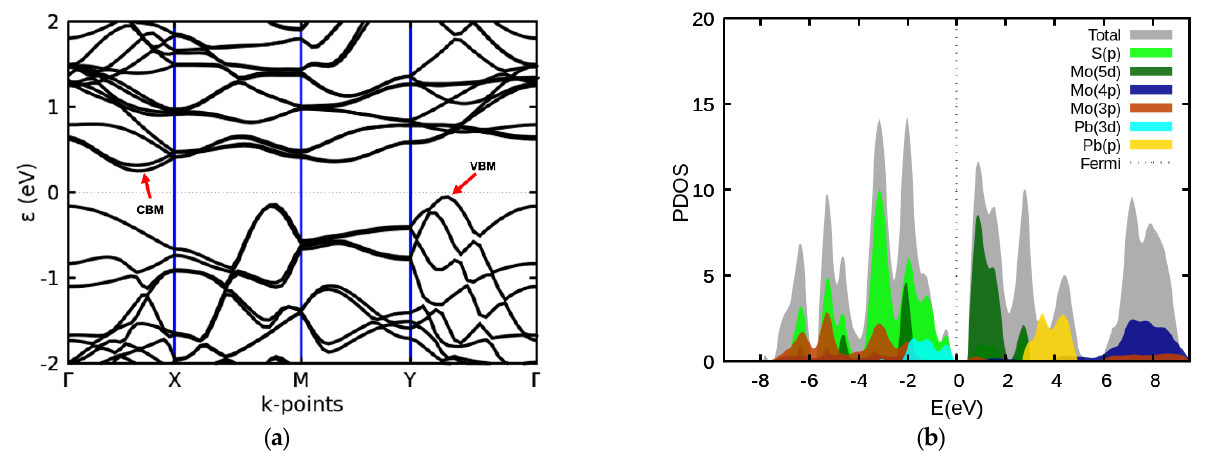
Figure 2. Calculated ( a ) band structure and ( b ) partial density of states of the 2D QH MoS 2 -PbS heterostructure. The conduction band minimum (CBM) and valence band maximum (VBM) are indicated in ( a ).